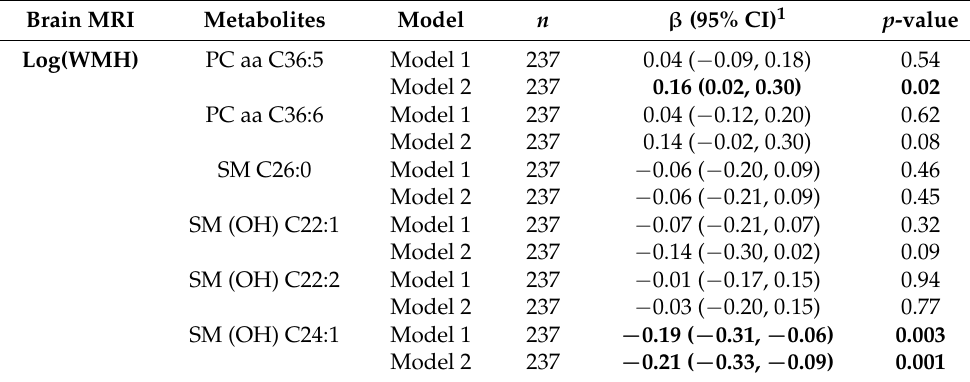
Table 3. Weighted* cross-sectional associations of plasma metabolites (log-transformed per 1-SD difference) with WMH (log-transformed), Atherosclerosis Risk in Communities (ARIC) Study, 2011 to